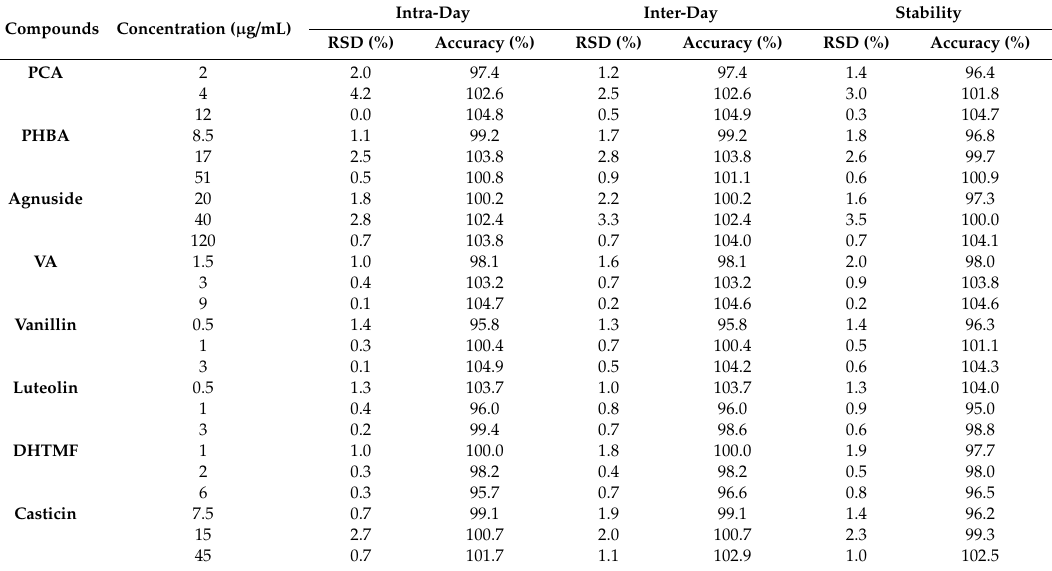
Table 2. The results of precision and stability.